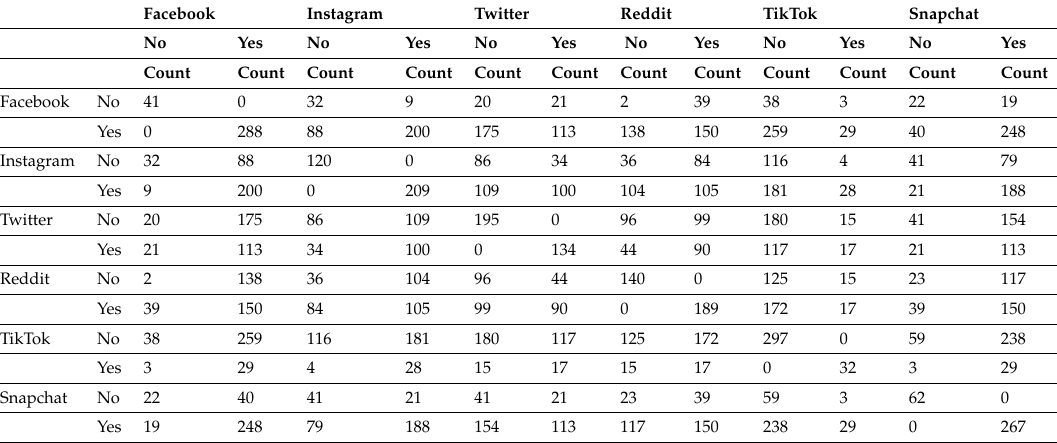
Table A1. Overlap between users and